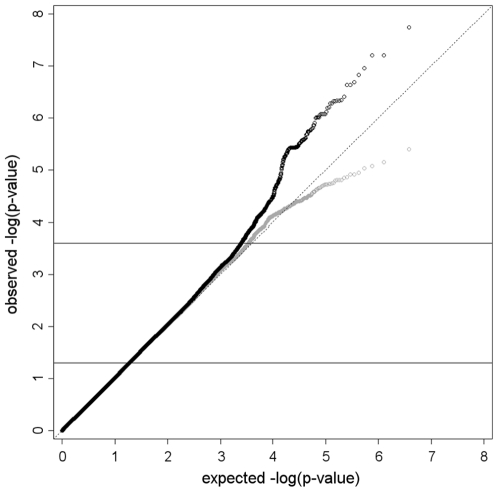
Quantile-quantile plots of association results of the meta-analysis from TwinsUK, BRIGHT and DCCT/EDIC cohorts.Based on 2,399,142 SNPs in 3,558 individuals from the combined cohorts. The −log10(P) plot of association test for QT interval is shown for all SNPs (black diamonds) and for all SNPs except those located within 1 Mb of the most significant SNPs of our five associated regions (dark grey) [26]. Genomic Control λ was 1.016 [25]. The lower horizontal line denotes the 95% percentile of the results of all SNPs, values lower than this threshold were used for calculating the λ. The upper line indicates the point from where P-values of the complete dataset deviate from the expected line.